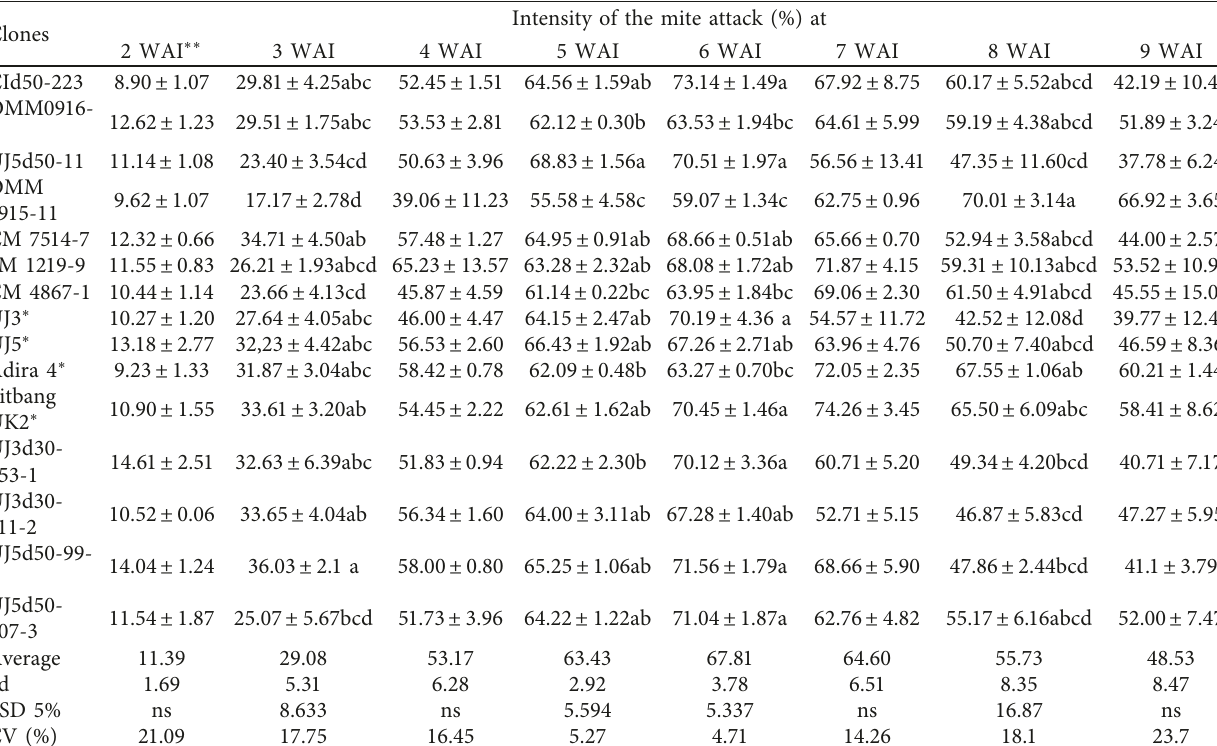
SE) of promising clones, glass house of ILETRI, 2018. Intensity of the mite attack (%) at ±